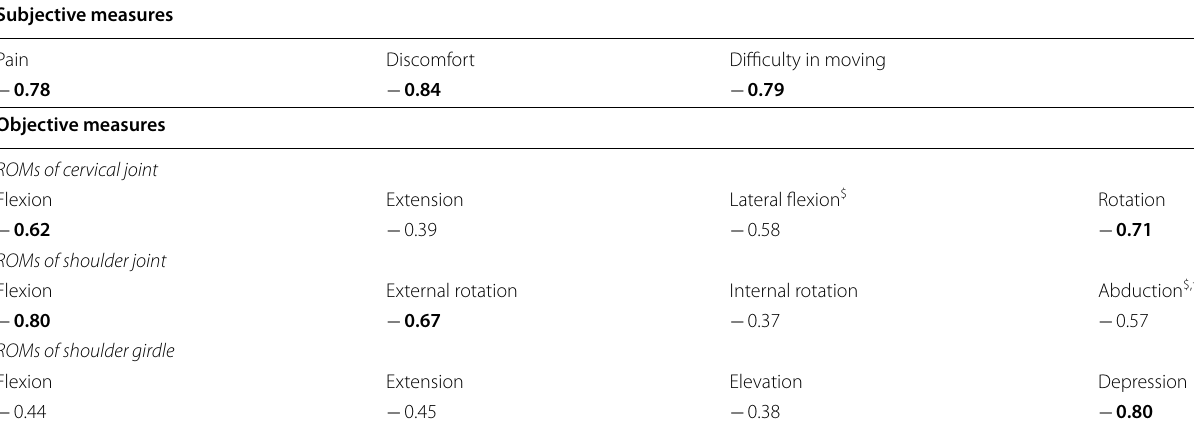
Table 2 The correlation coefficients (r) between baseline values and changes in subjective and objective measures